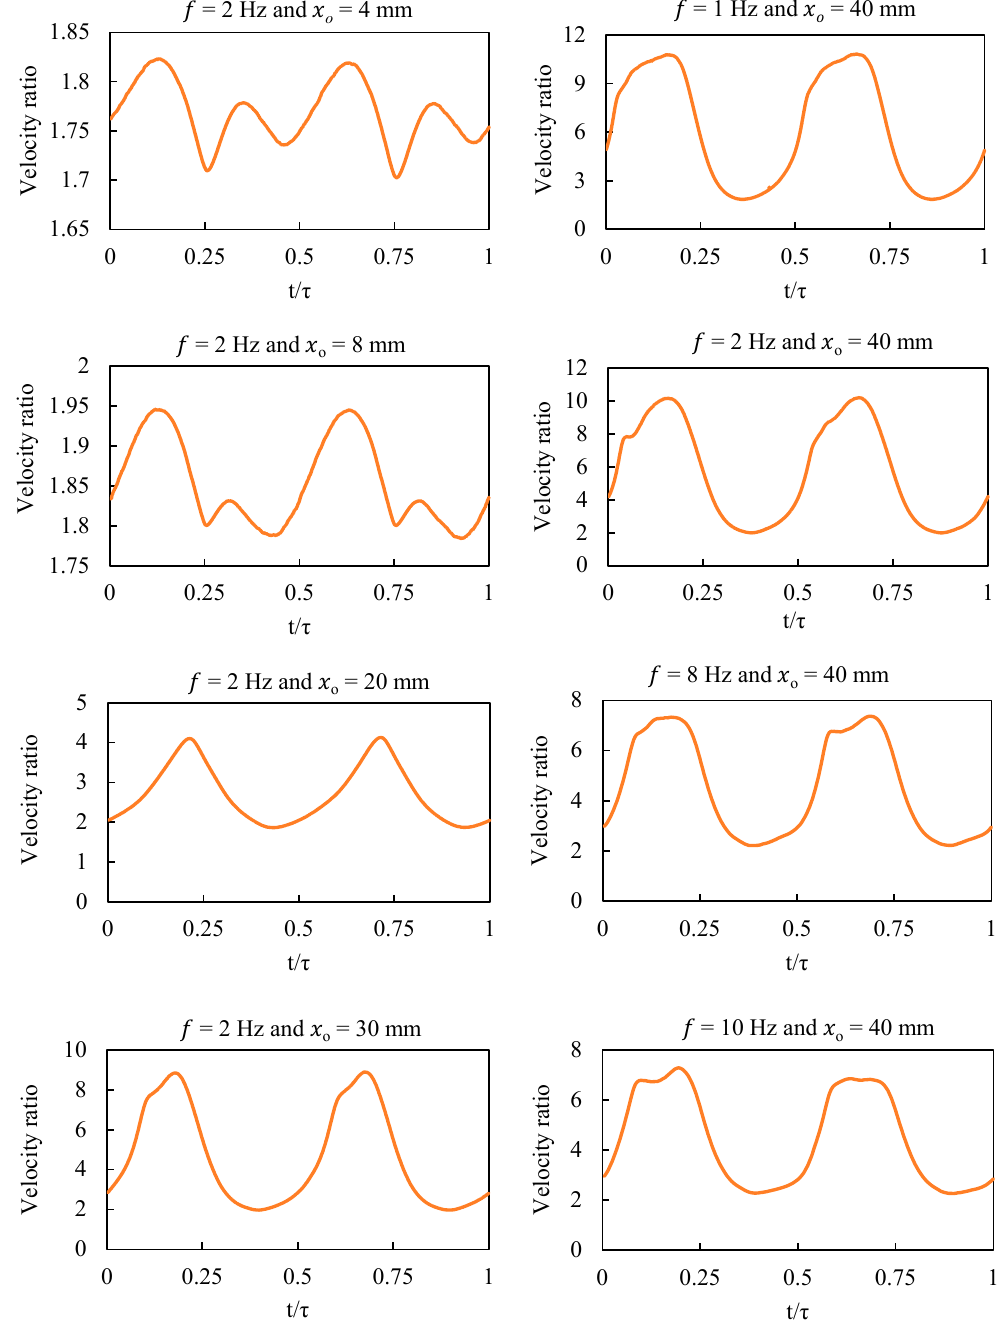
Figure 6. Velocity ratio vs dimensionless oscillation time (t/ τ ) for different oscillation conditions indicated above each plot.